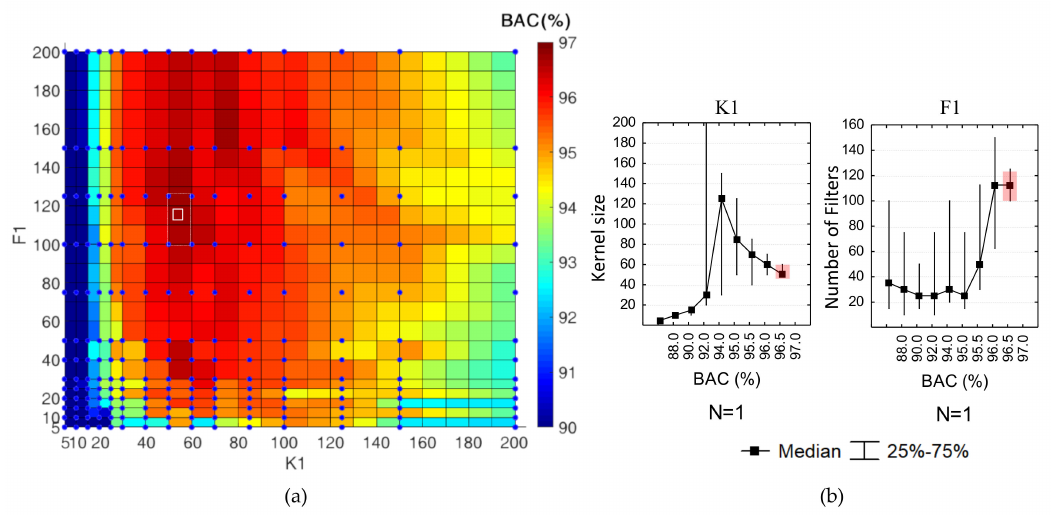
Figure 5. Analysis of HPs = { K 1 , F 1 , } of random search CNNs with one convolutional block ( N = 1):( a ) Colormap of validation performance: BAC = f { K 1 , F 1 , } generated in a fine surface grid by four-nearest-neighbors interpolation between the measurement points of the search grid (blue dots). The highlighted white zone covers the HPs of the top-ranked performance models, i.e., HPrank quartile range (rectangle) and HPopt = HPrank median value (square); ( b ) statistical distributions of { K 1 , F 1 , } = f ( BAC ) , presented as median values (dots) and quartile ranges (whiskers). HPrank quartilerangeofthetoprankedperformancemodelsishighlightedintherightmostdistributions, corresponding to BAC ≥